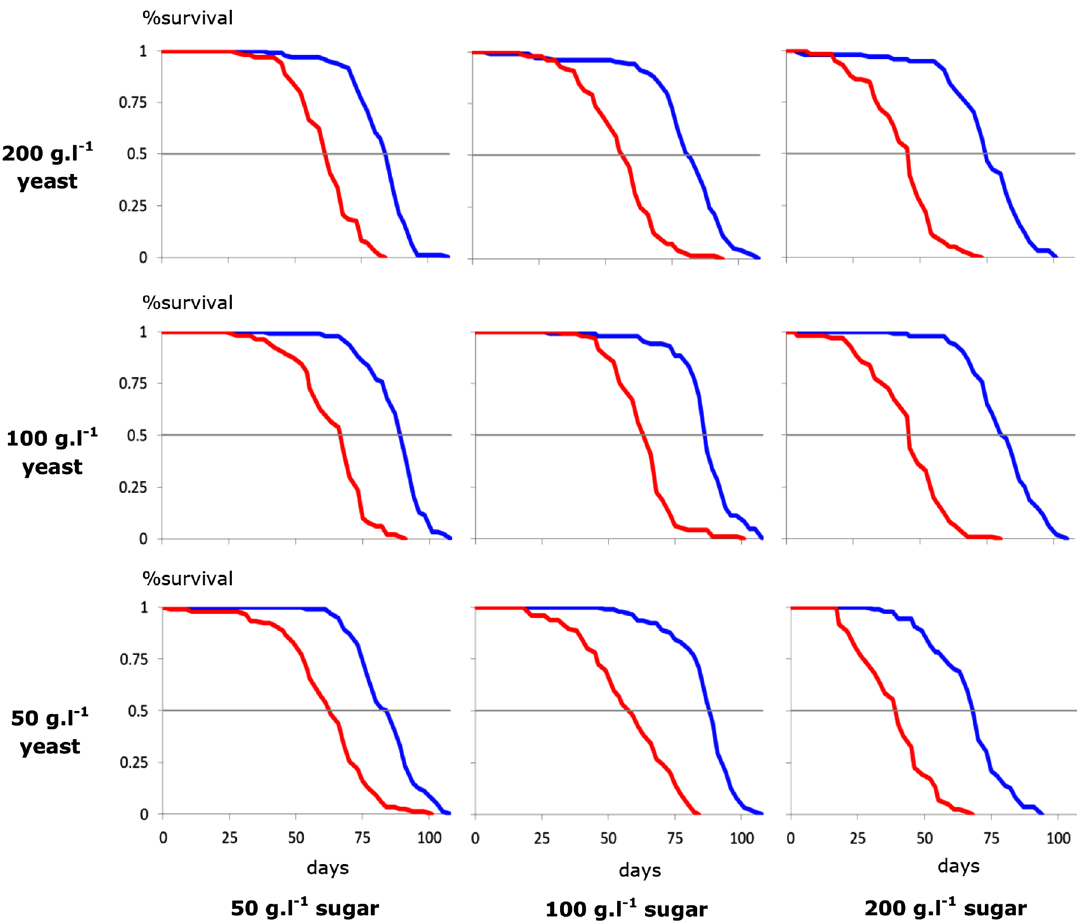
Fig. 1 Lifespan curves for dilp2-3,5 mutant ( blue ) and control fl ies ( red ) for all nine food types. On each row the lifespan response to one level of dietary yeast is shown for three different levels of sugar (50, 100 and 200 g l − 1 ,